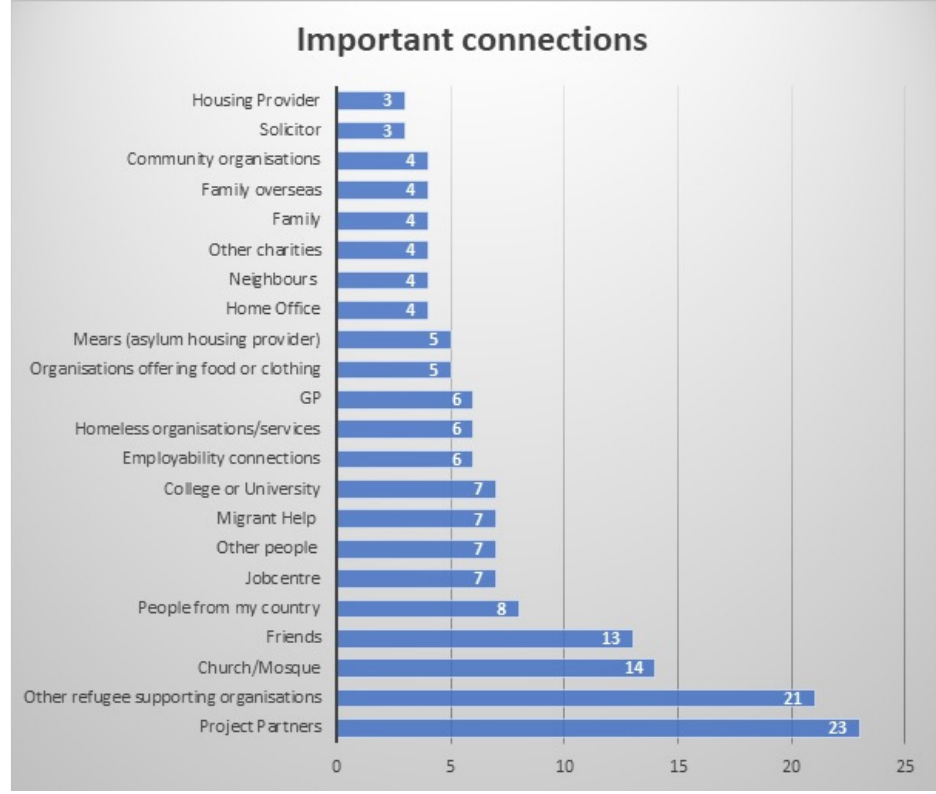
Figure 2. Important connections based on how many times these came up in bullseye conversations, regardless of how important these were stated to be.